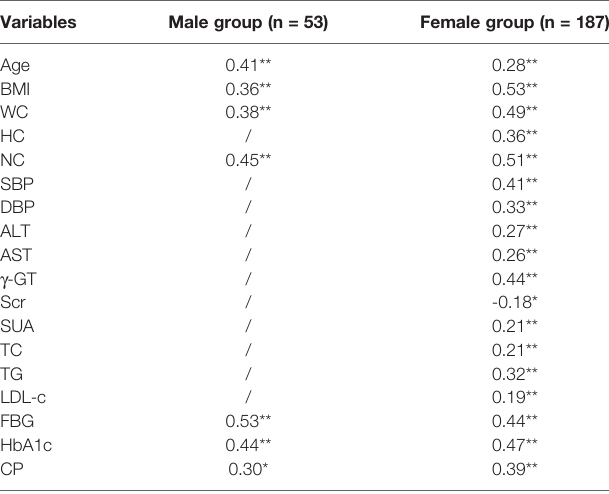
TABLE 2 | The correlation coef fi cient of VFA with demographic and anthropometric variables in derivation cohort.